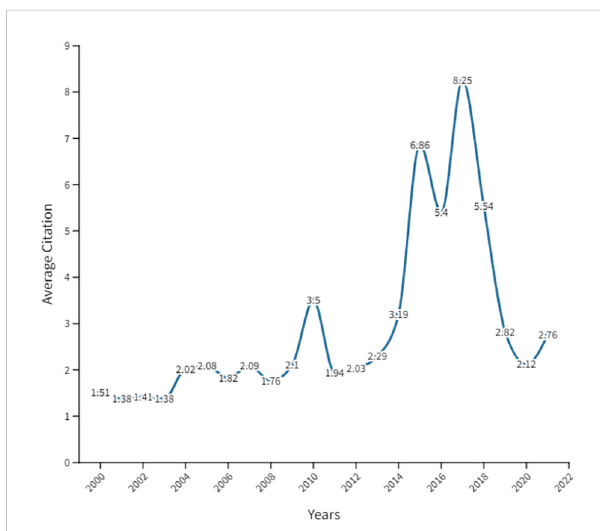
FIGURE 2 The average annual citations of cancer research publications in FCS in the MENA region from 2000 to 2021.